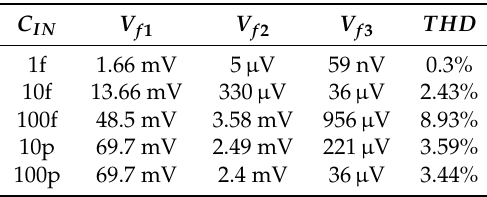
Table 3. THD analysis